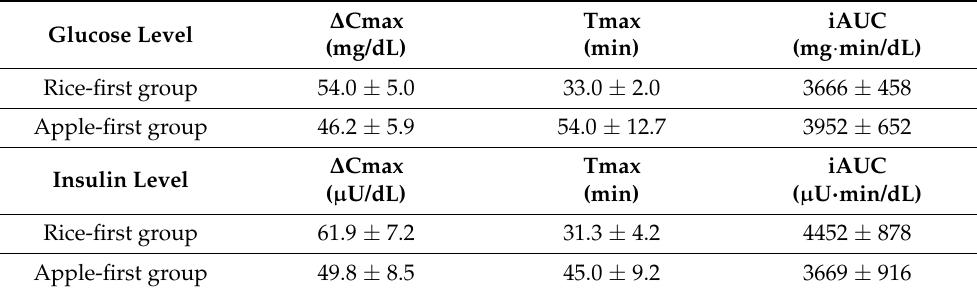
Table 2. Dynamic parameters of blood glucose and insulin levels in the normal subjects. ∆ Cmax Tmax iAUC Glucose Level (mg/dL) (min) (mg · min/dL) Rice-first group 54.0 ± 5.0 33.0 ± 2.0 3666 ± 458 Apple-first group 46.2 ± 5.9 54.0 ± 12.7 3952 ± 652 ∆ Cmax Tmax iAUC Insulin Level ( µ U/dL) (min) ( µ U · min/dL) Rice-first group 61.9 ± 7.2 31.3 ± 4.2 4452 ± 878 Apple-first group 49.8 ± 8.5 45.0 ± 9.2